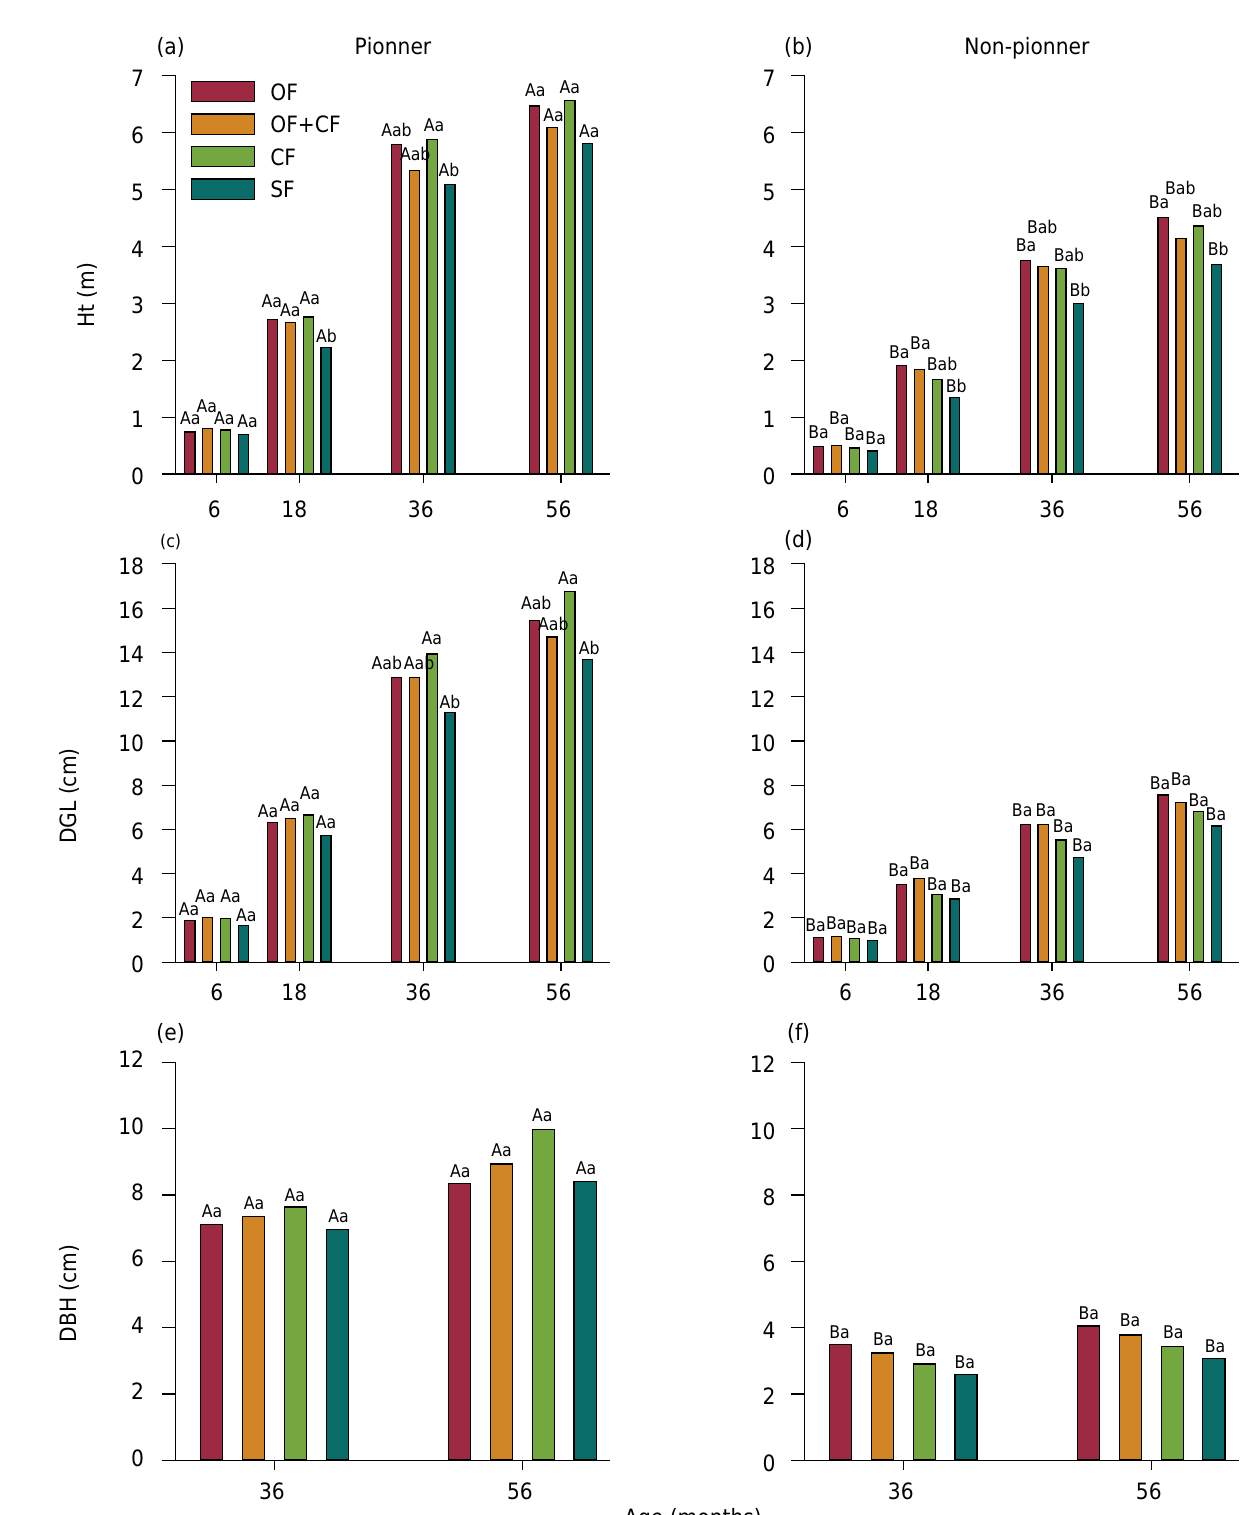
Figure 4. Growth in height (Ht; a) in native pioneer forest species and non-pioneer species (b); trunk diameter at ground level (DGL; c) in native pioneer forest species and non-pioneer (d); trunk diameter at breast height (DBH; e) in native pioneer forest species and non-pioneer species planted in an area of bauxite mining (f) at 6, 18, 36, and 56 months of age, submitted to organic (OF), combined organic and chemical (OF+CF), chemical (CF), and standard (SF) fertilizers. Uppercase letters compare pioneer and non-pioneer species for each age, and lowercase letters compare fertilization treatments within the same age and the same group and, when equal, indicate no differences between them by the Tukey’s test at 10 % probability